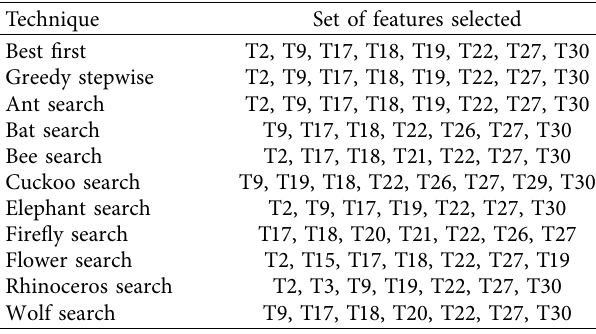
Table 8: Feature subset selection results for dataset